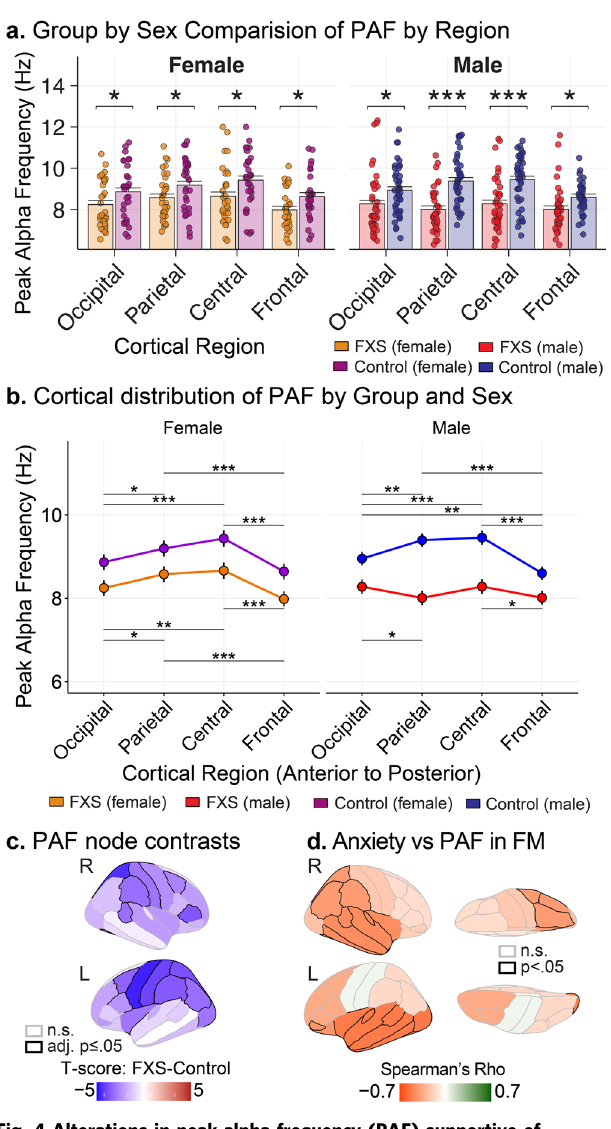
Fig. 4 Alterations in peak alpha frequency (PAF) supportive of thalamocortical dysrhythmia in FXS patients. The slowing of alpha oscillations have been observed across scalp potentials and intraoperative recordings and is suggestive of abnormalities in thalamocortical activity in several neuropsychiatric conditions. a Bar plots (model estimated mean ± standard error of least-squared mean estimates) comparing regional PAF by groups matched by sex. Scatter plot of observed subject- level PAF values are superimposed over model estimates. Participants with FXS ( n = 70) have slower PAF across all cortical regions than controls ( n = 71). b Line plots ± standard error of least-squared mean estimates comparing the within-subject distribution of PAF across posterior-anterior cortical regions. Males with FXS have a relatively even distribution of PAF across the posterior-anterior axis with no prominent central elevation as seen in matched controls. c Visualization of mean FXS-control differences of PAF by cortical node. Participants with FXS have broadly reduced PAF with the most prominent reductions in central and parietal nodes. See Supplementary Fig. 3 for node atlas. d The severity of anxiety is inversely associated with PAF. Visualization of cortex plotting age-corrected Spearman correlations in full-mutation, non-mosaic males (FM; n = 27; r (25) = − 0.41 to − 0.53, p ≤ 0.05). FM full mutation, FXS non-mosaic males, LO left occipital. Horizontal black bars: FDR-adjusted, post-hoc testing; *adj. p ≤ 0.05; **adj. p ≤ 0.01; ***adj. p . ≤ 1 × 10 − 5